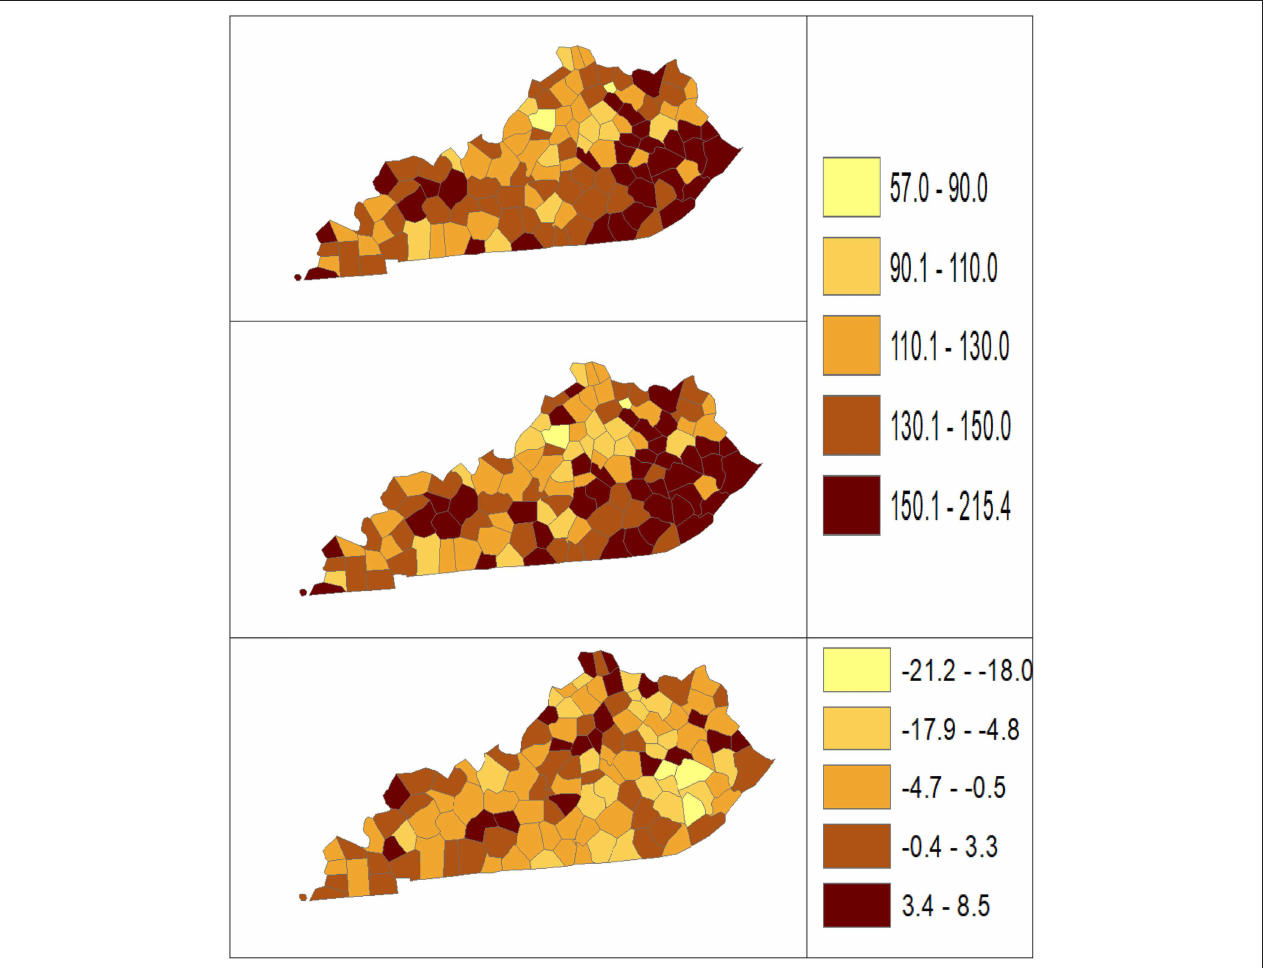
FIGURE 1 | Age-adjusted rate estimated from statistical methods (Direct top vs. BCM middle) and their difference (bottom) using 2006–2010 lung cancer incidence data in Kentucky